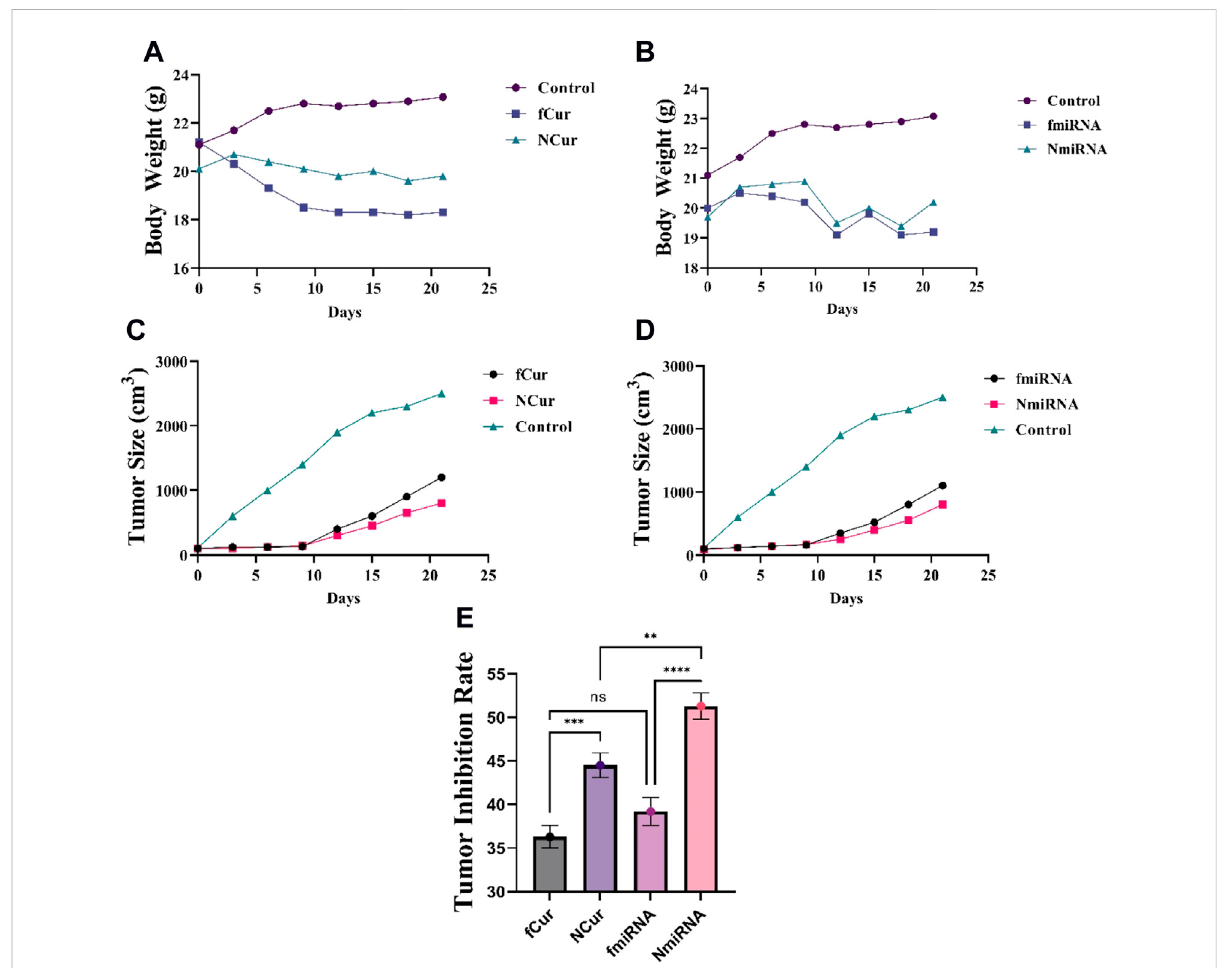
FIGURE 10 (A,B) Effect of Cur and miRNA formulations on the bodyweight at every 3-day-intervals, respectively. (C,D) The tumor size (cm 3 ) of different mice groups after 21 days of receiving the medicine. All groups displayed a major decrease ( p < 0.05) in the tumor volumes than the control group after 14 and 21 days. (E) Tumor inhibition rate.